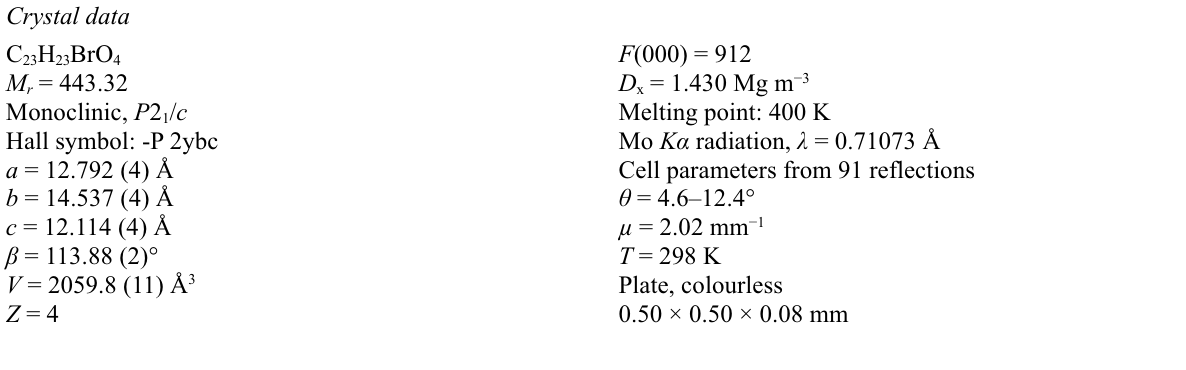
The packing diagram of the title compound, viewed along the c axis showing weak C—H···O and C—H··· π interactions Ethyl